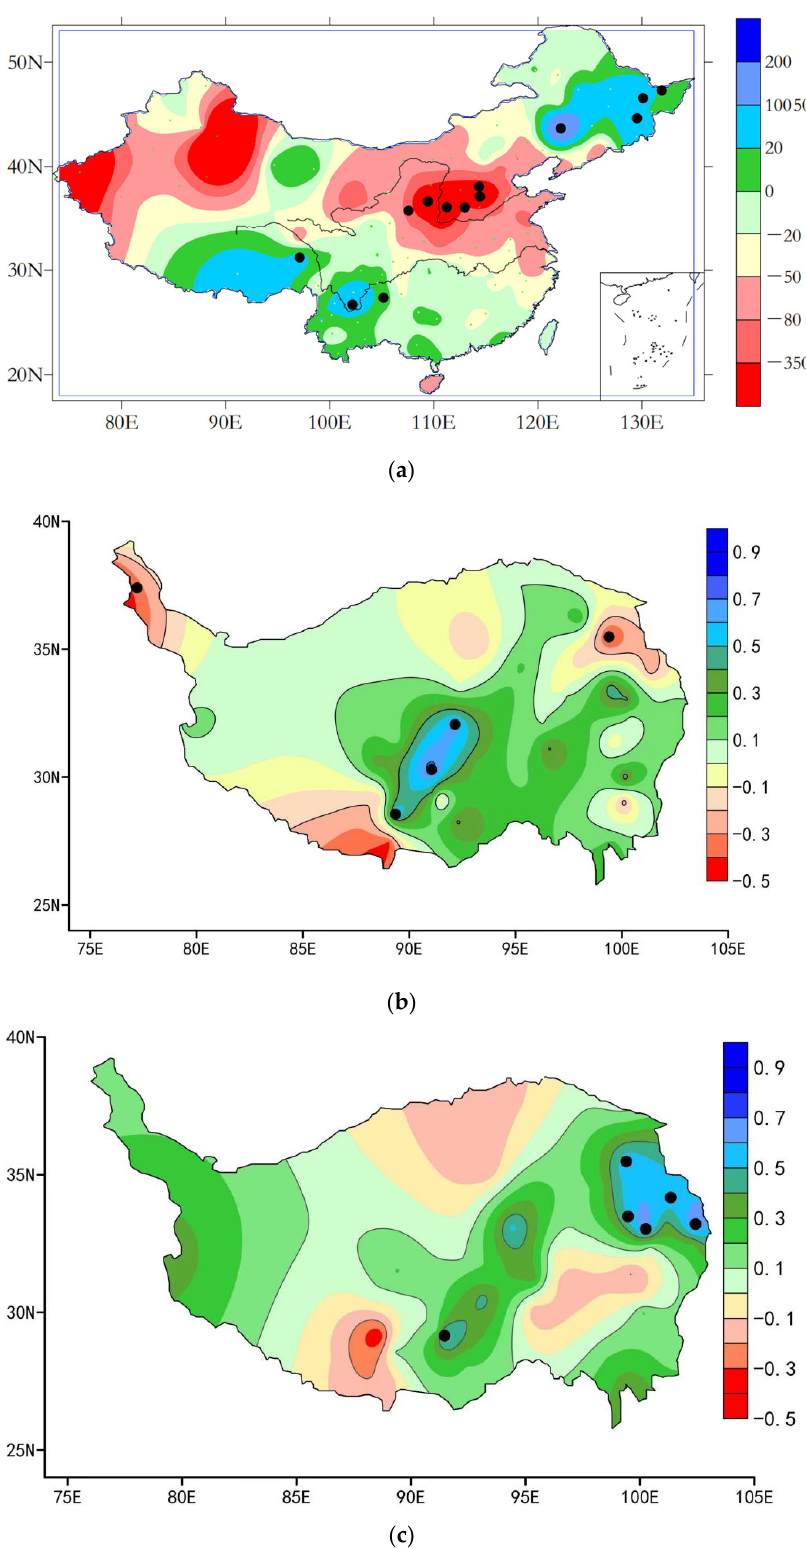
Figure 3. ( a ) Differences in winter precipitation in China between peak and valley years of SRF. The black dots represent stations that passed the 0.1 significance test. ( b ) Differences between high and low SRF years of the plateau snow days in winter and ( c ) the plateau snow days in spring ( • indicates the stations that passed the 0.1 significance test). (Units: latitude is ◦ N, and longitude is ◦